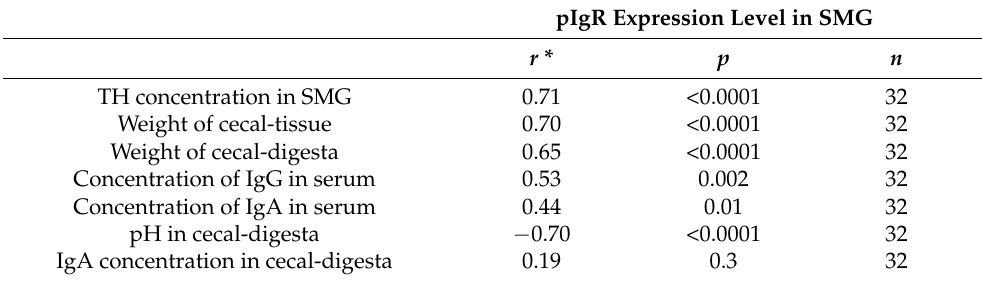
Table 3. Correlation between polymeric immunoglobulin receptor (pIgR) expression level in sub- mandibular gland (SMG) and different